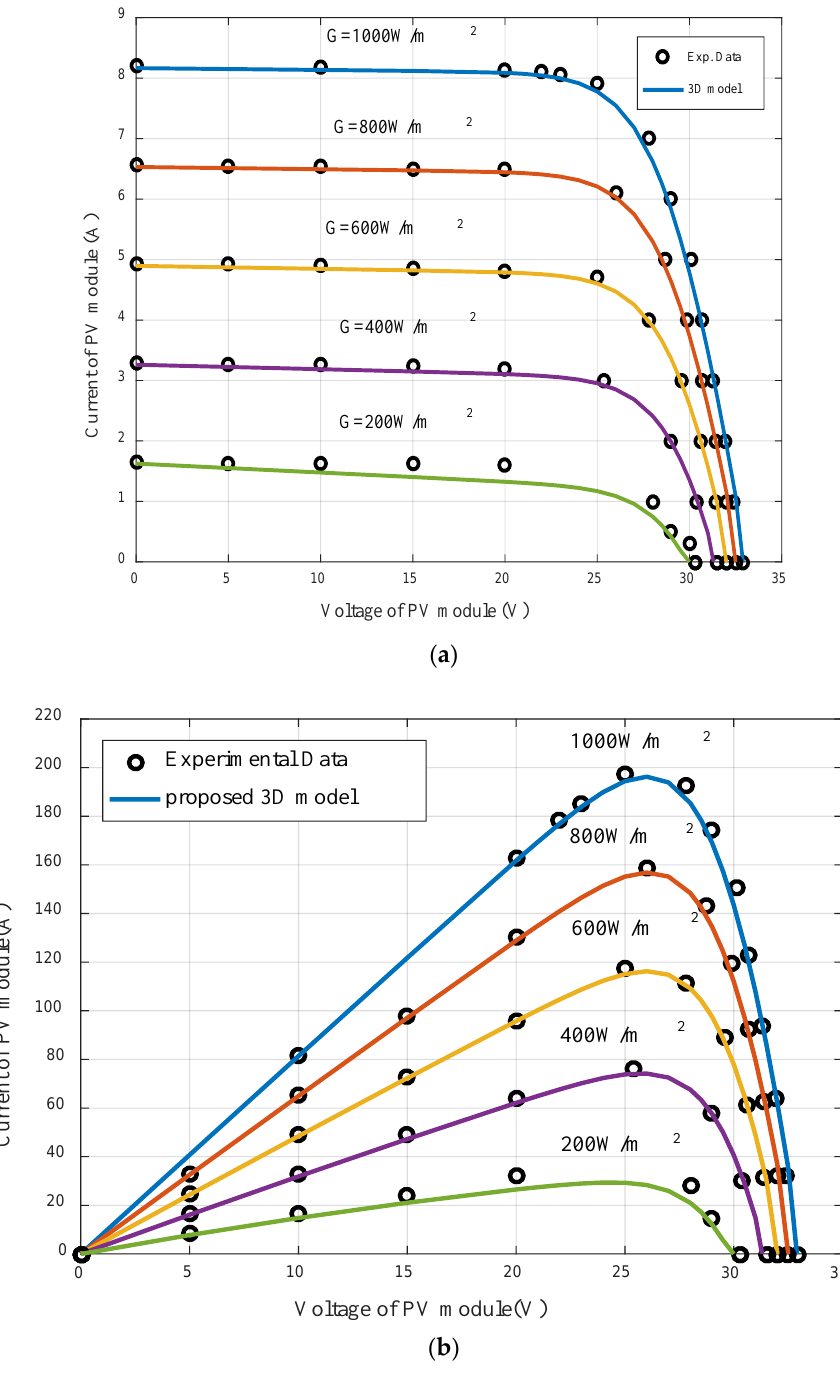
Figure 5. GOA-based simulation results and practical data of KC200GT module at various irradiation conditions, temperature = 25 °C ( a ) I-V curves; ( b ) P-V curves.